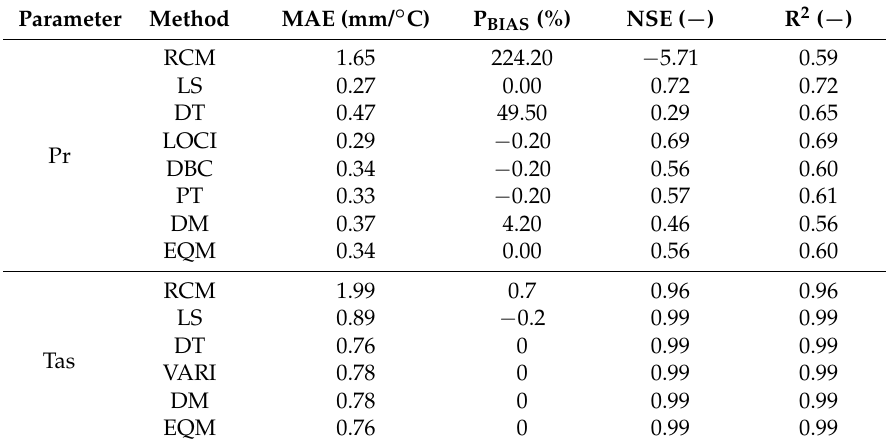
Table 3. Time-series-based metrics of original and corrected precipitation as well as temperature on an average daily scale at the BYBLK station.